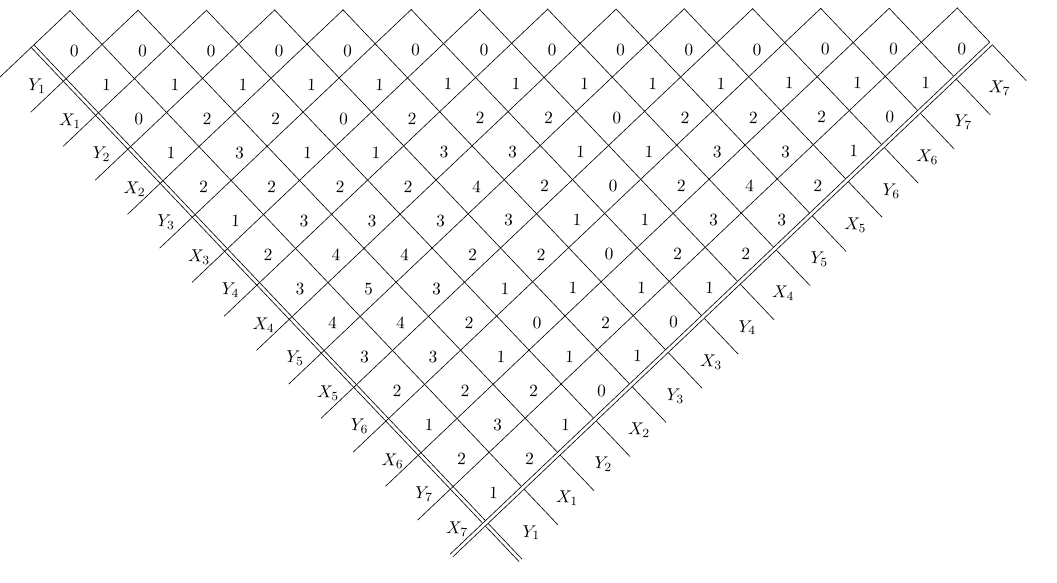
Figure 3 . The kinematic space and overlap number h ( Z i ; Z j ) for the phase depicted in (cid:12)gure 2. groups which fall in between the consecutive components of c